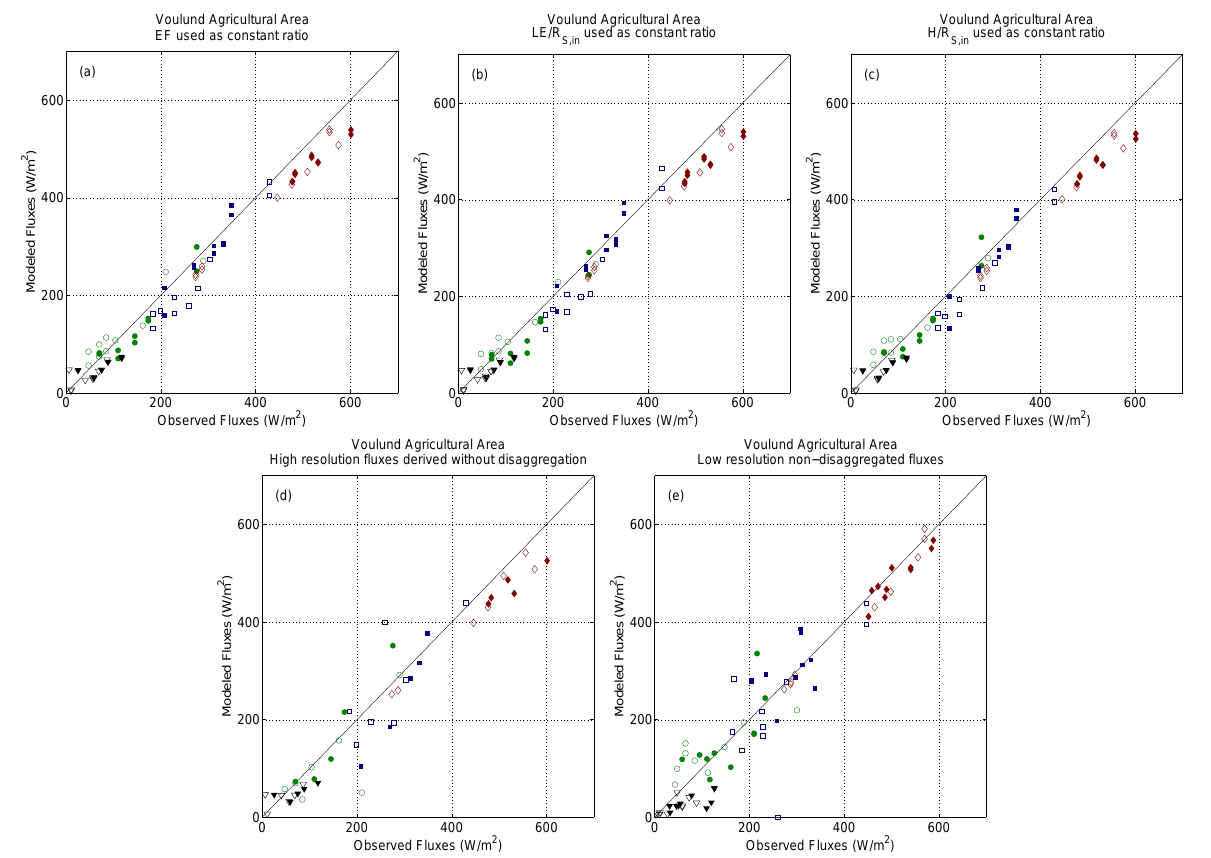
Figure 5. Comparison of modelled vs. observed fluxes at the Voulund agricultural area. Modelled fluxes are instantaneous at the time of satellite overpass and observed fluxes are 30min averaged EC measurements. The three approaches used for determining the constant ratio during the disaggregation are: (a) evaporative fraction, (b) LE /R s, in , (c) H/R s, in . Panel (d) shows high-resolution fluxes derived with TSEB model without disaggregation. The modelled fluxes in those panels are produced at 30m spatial resolution and are aggregated to EC footprint. Panel (e) shows the low-resolution, non-disaggregated fluxes modelled with DTD. Rectangles represent LE, circles represent H , triangles represent G and diamonds represent R n . Empty symbols indicate aggregated fluxes where pixels comprising 70% of EC footprint were present (S70 set), and full symbols where in addition there were no missing Landsat pixels within the MODIS pixels (S100 set).